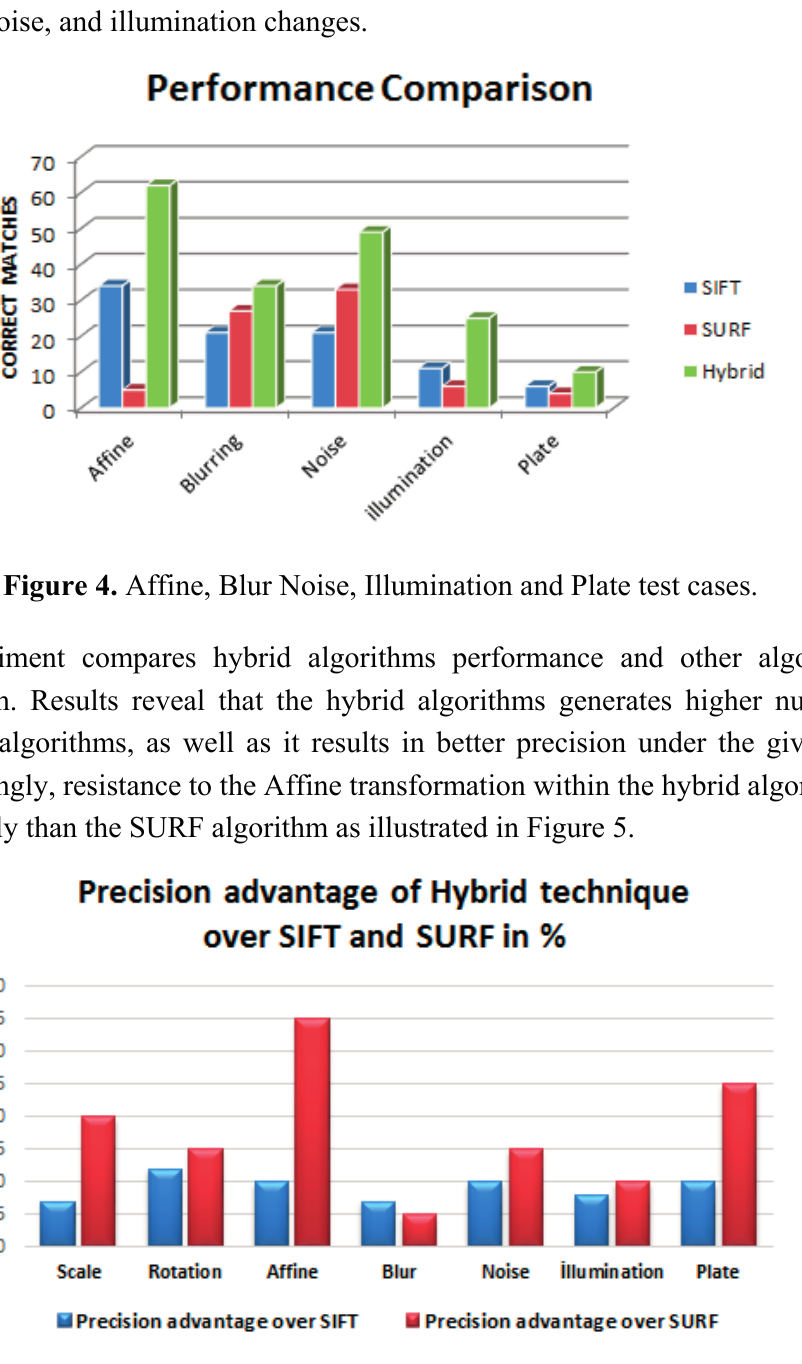
Figure 5. Precision comparisons between